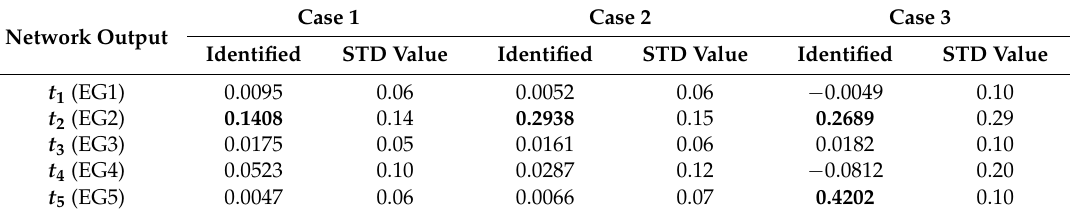
Table 5. Prediction results of the Bayesian neural network.